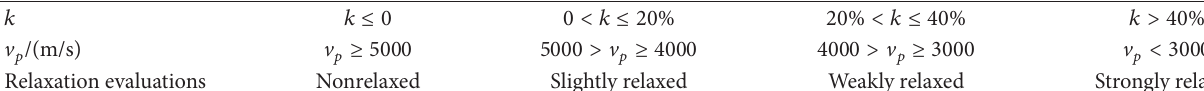
Table 3: Classification criteria of relaxation degrees.